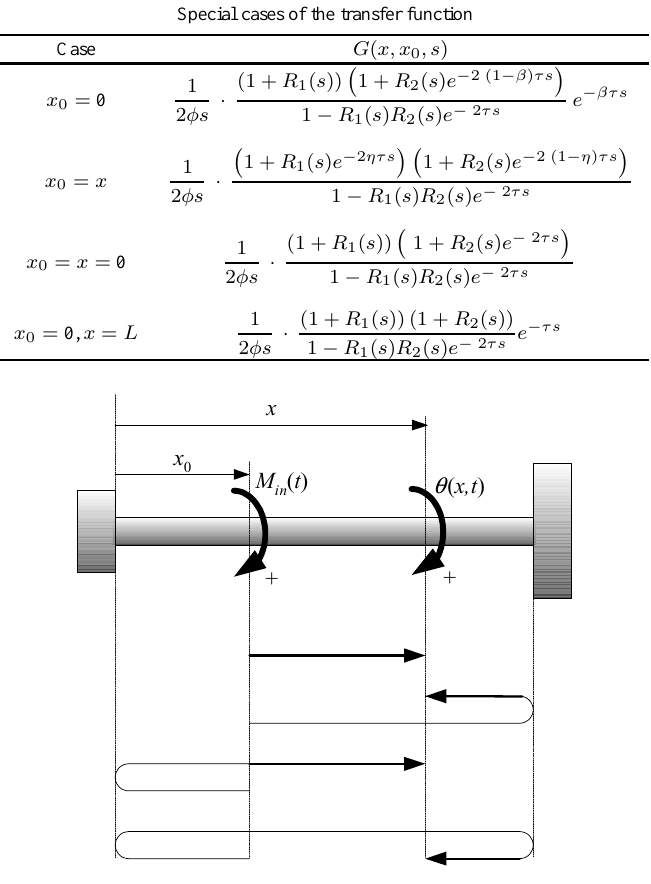
Fig. 2. The four time delays in the numerator of the transfer function in Eq.